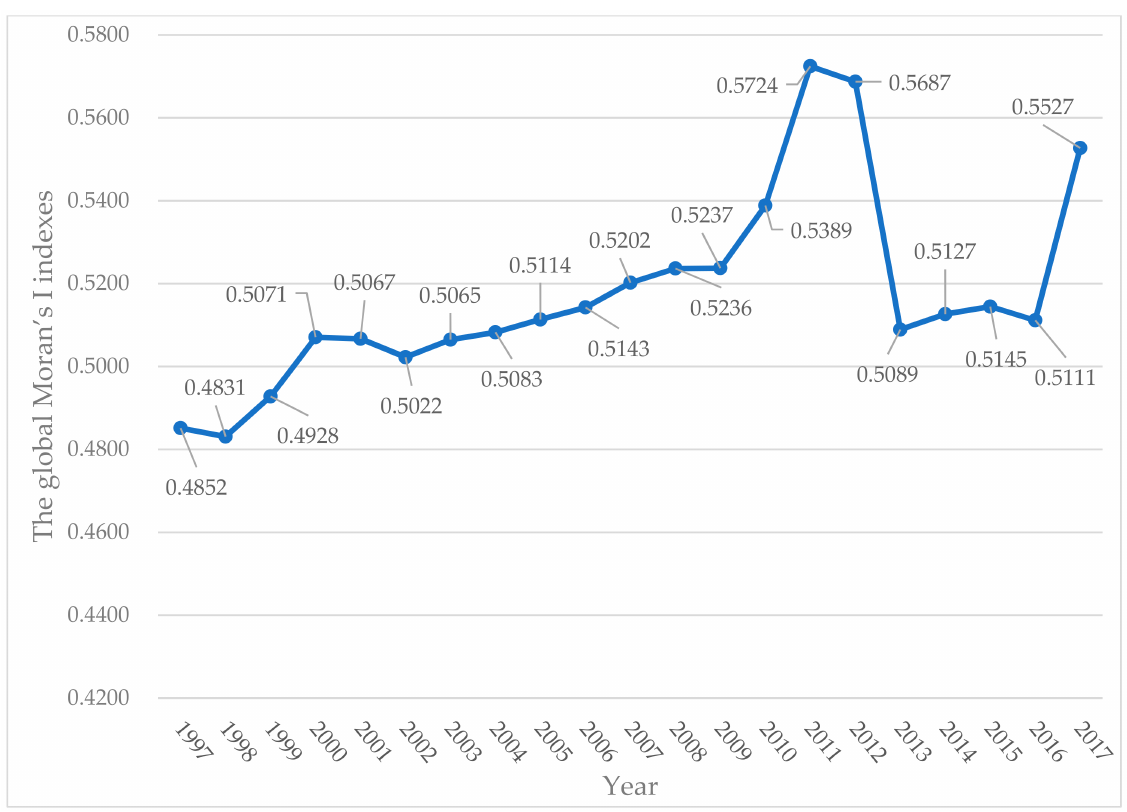
Figure 2. The global Moran’s I indexes of the Harbin–Changchun urban agglomeration from 1997 to